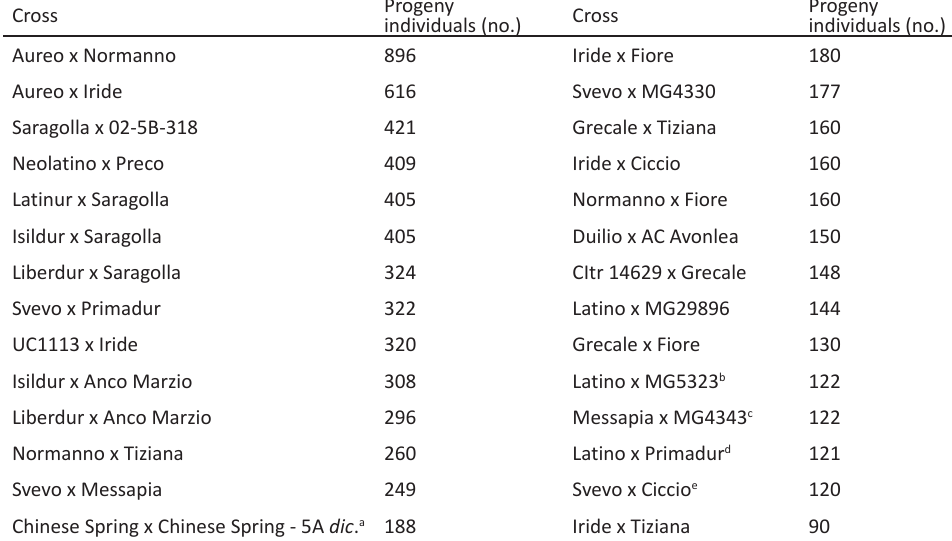
Table 2. Pairs of parental lines and progeny size of 28 wheat mapping populations set up at the Genetics and Plant Breeding Unit, Department of Soil, Plant and Food Sciences, University of Bari, Italy Cross Progeny Cross Progeny individuals (no.) individuals